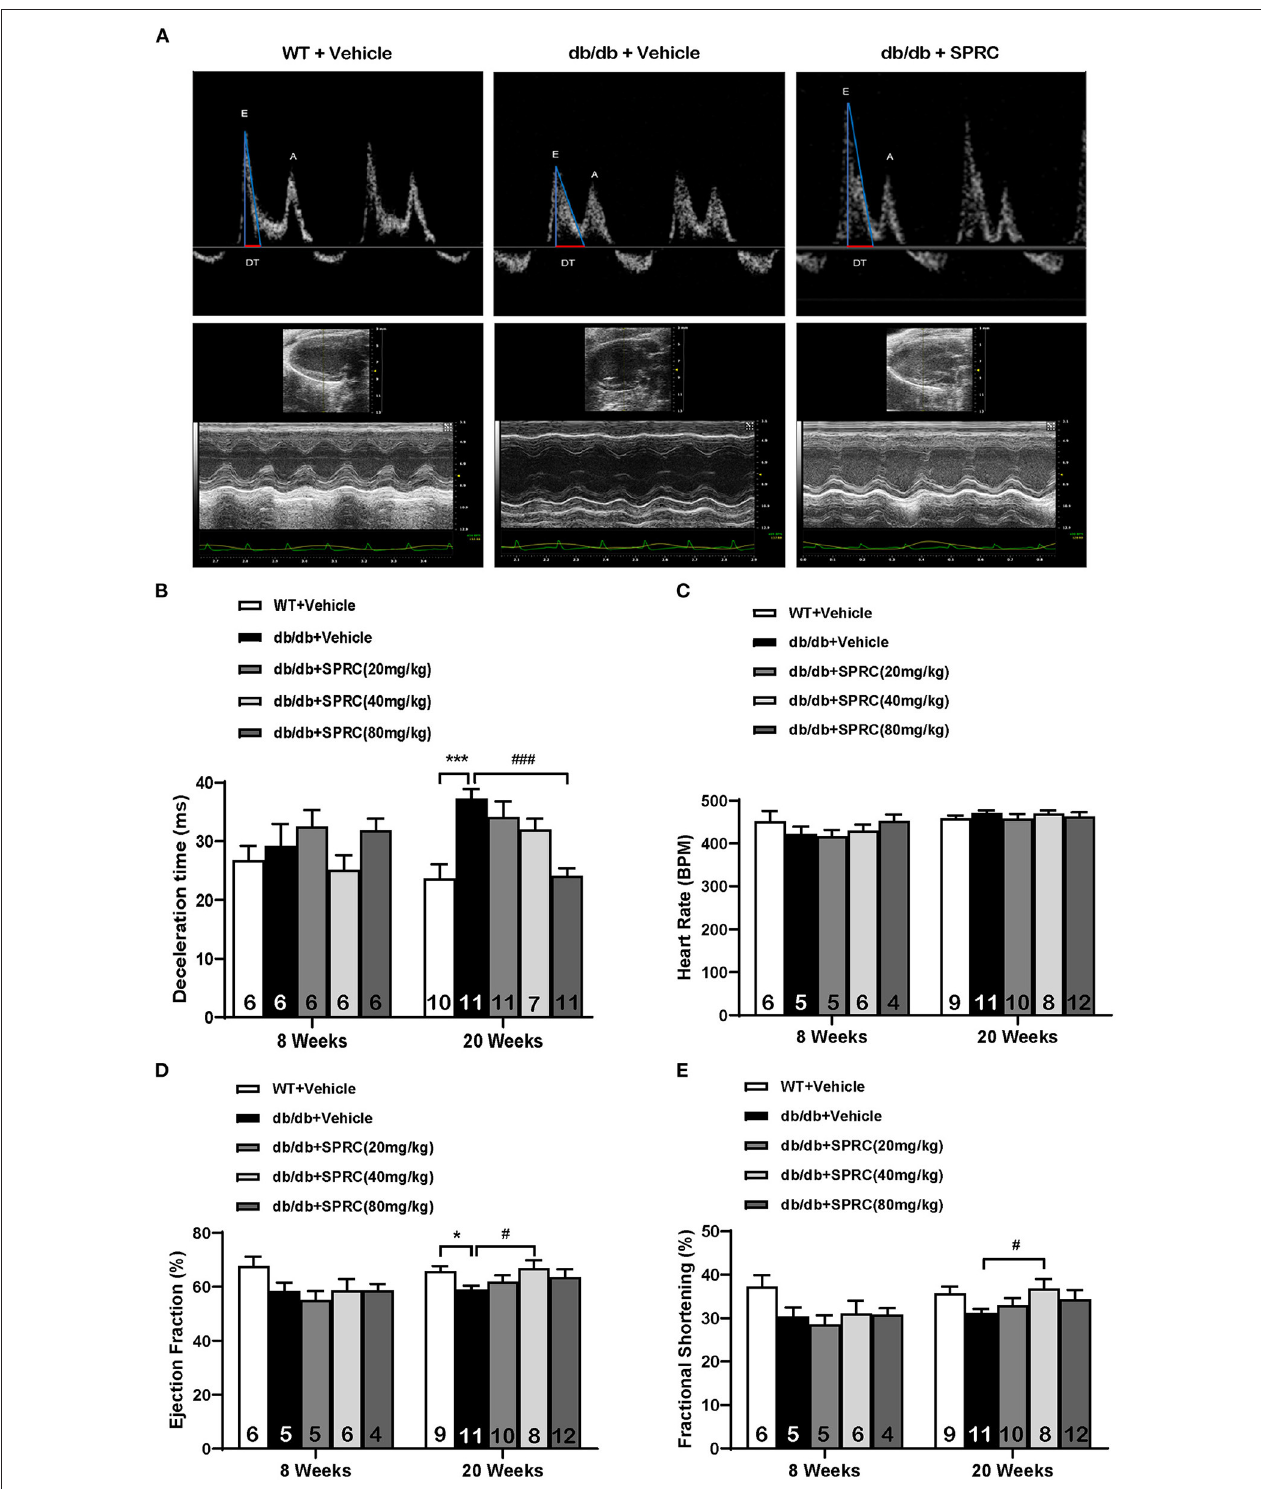
FIGURE 1 | SPRC treatment improves cardiac function in db/db mice. Vehicle or SPRC (20, 40, or 80 mg/kg/day) was orally administered to WT mice or db/db mice for 12 weeks. Echocardiograph images were recorded before and after 12 weeks of SPRC treatment. (A) Representative Power Doppler Mode (upper) and M-Mode (lower) echocardiograph images. (B–E) Echocardiographic assessment of deceleration time (DT), heart rate (HR), left ventricular ejection fraction (EF), and fractional shortening (FS). Values are presented as means ± SEM ( n = 4–12). * P < 0.05, *** P < 0.001 vs. WT + Vehicle group, # P < 0.05, ### P < 0.001 vs. db/db + Vehicle